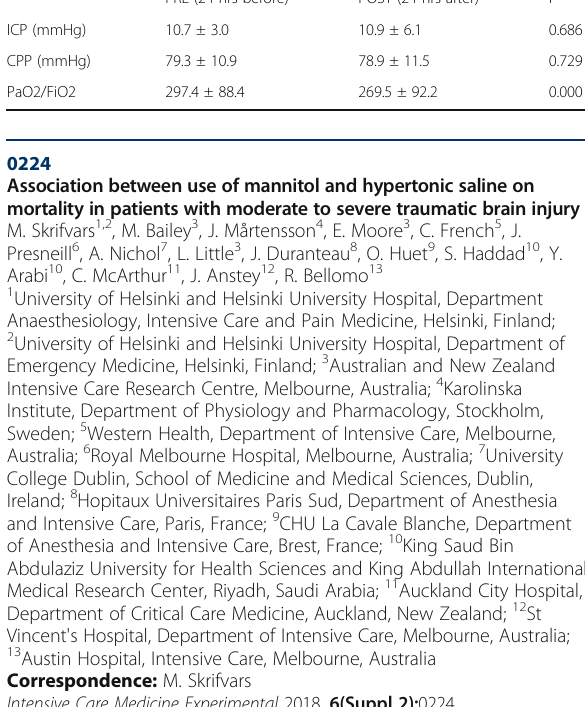
Table 1 (abstract 0223). Perioperative respiratory, hemodynamic and cerebral effects START